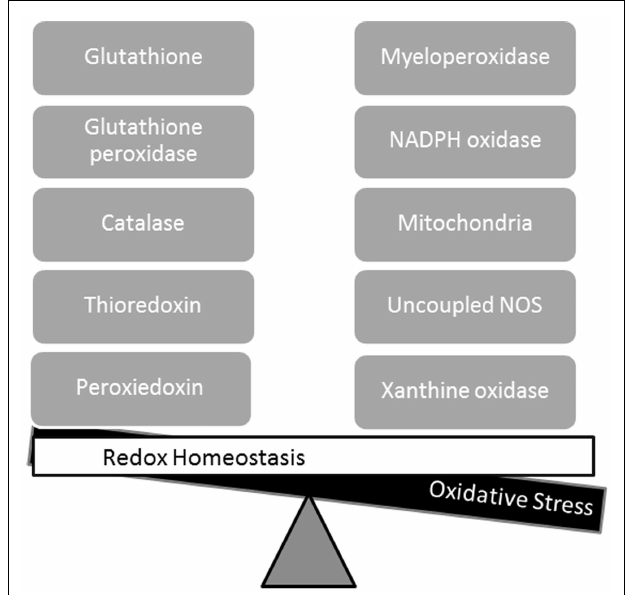
FIGURE 1 | Redox homeostasis is maintained by balanced interactions of reducing (left side) and oxidizing pathways (right side). Oxidative stress results from an imbalance in which oxidizing species exceed the reducing capacity of the cell.